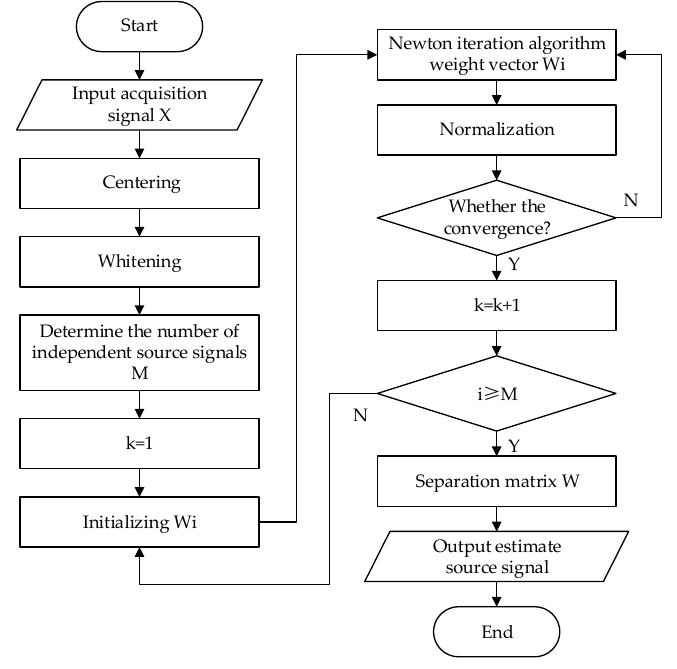
Figure 3. Flowchart of FastICA algorithm.